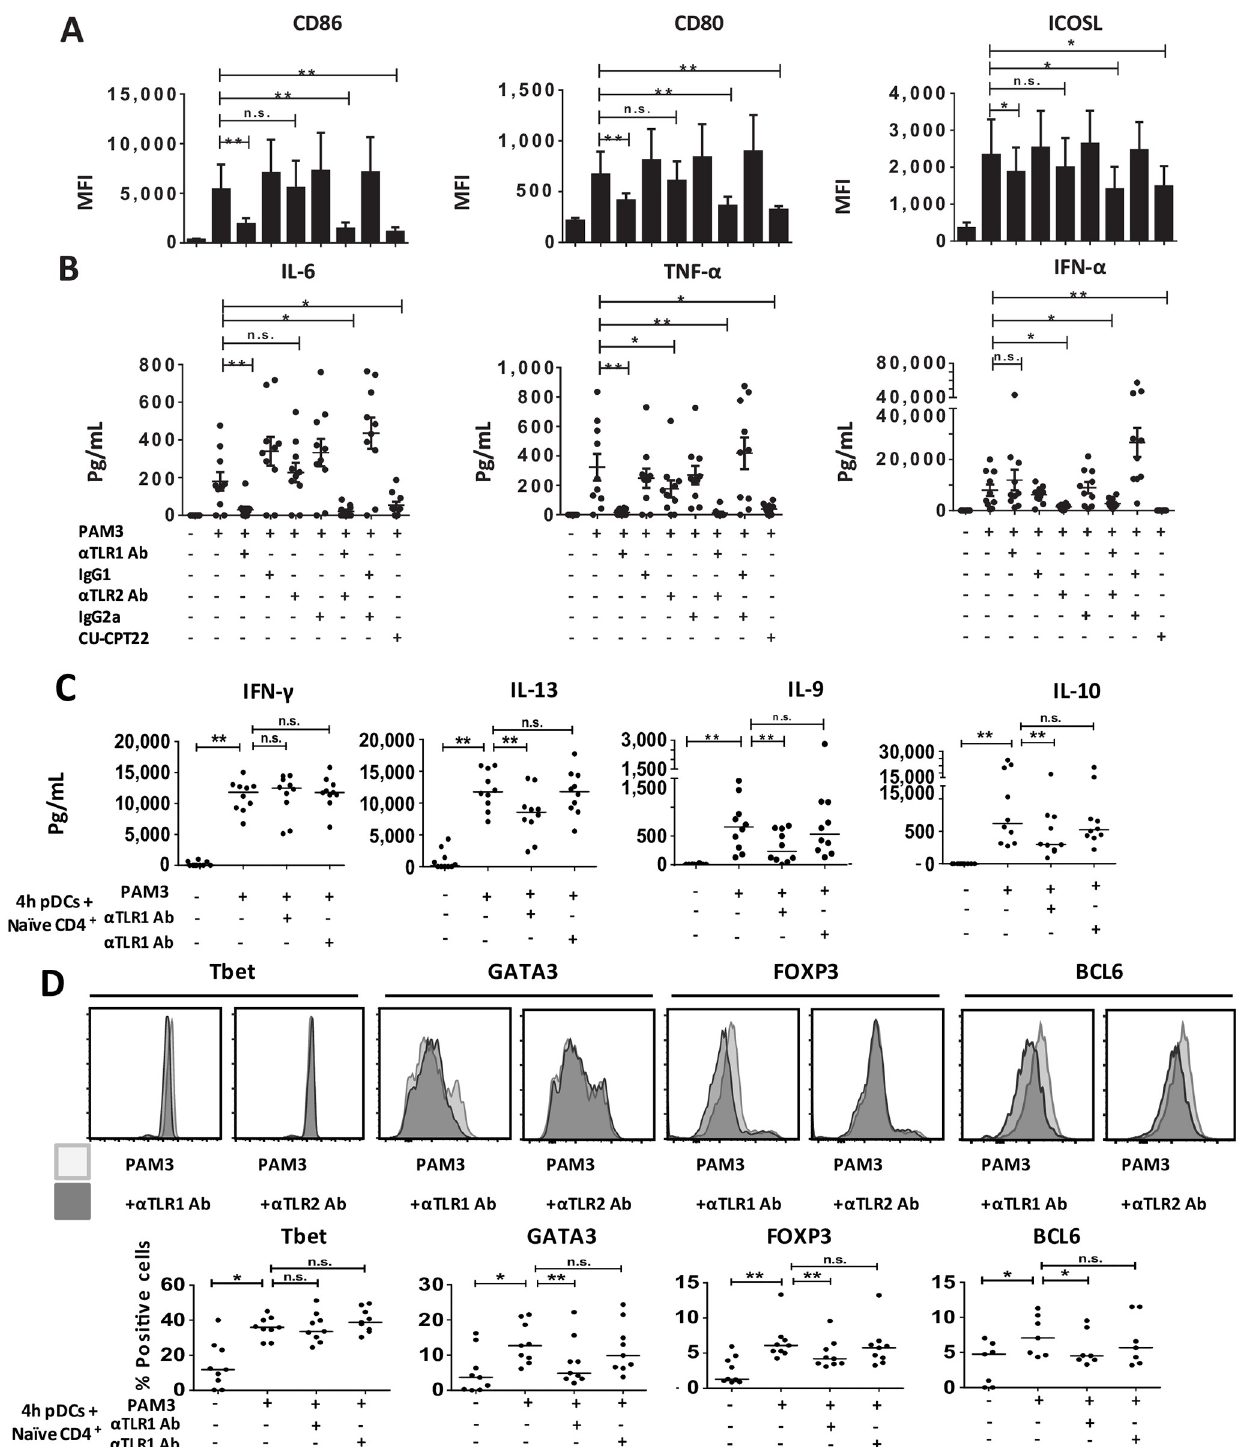
Fig 3. TLR1 and TLR2 functional blocking has a differential impact on pDC innate and adaptive functions. (A–B) Sorted human pDCs were cultured during 24 hours with medium ( Ø ) or PAM3 in the presence or not of TLR1 neutralizing antibody ( α TLR1 Ab), TLR2 neutralizing antibody ( α TLR2 Ab), or IgG1 isotype control antibody (IgG1); or IgA2 Isotype Control (IgG2a), double blocking (TLR1 Ab + α TLR2 Ab), double control isotype (IgG1 + IgG2a), or CU-CPT22. (A) MFI for surface expression of costimulatory molecules. Results include the mean of 9 independent donors. (B) Cytokine secretion by pDCs. Results include the mean of 10 independent donors. Each dot is an independent donor. (C–D) The 24-hour–stimulated pDCs were cocultured with